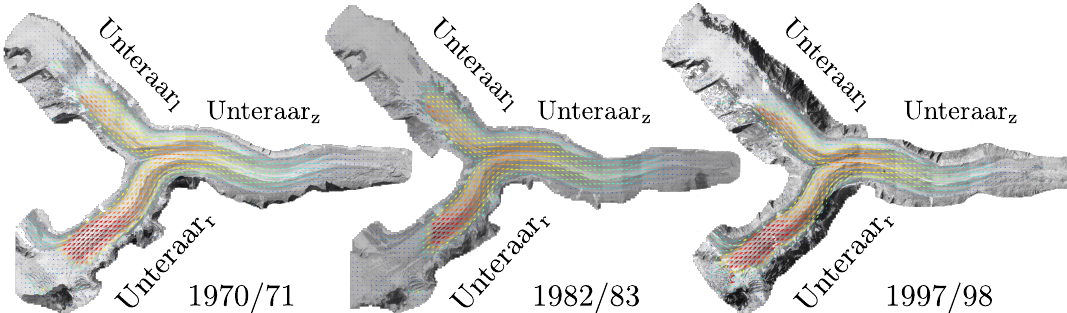
Figure 1: Reconstruction of all image pairs. Flow vectors are color coded w.r.t. their magnitude ( blue =slow flow, red =fast flow). Because of the large temporal gap between the acquisitions, changes in image appearance are inevitable, which make optical flow esti- mation challenging. Difficulties include varying snow coverage, non-uniform melt out or crevasse patterns, moving and tumbling rocks, shadows and generally different illumination conditions.